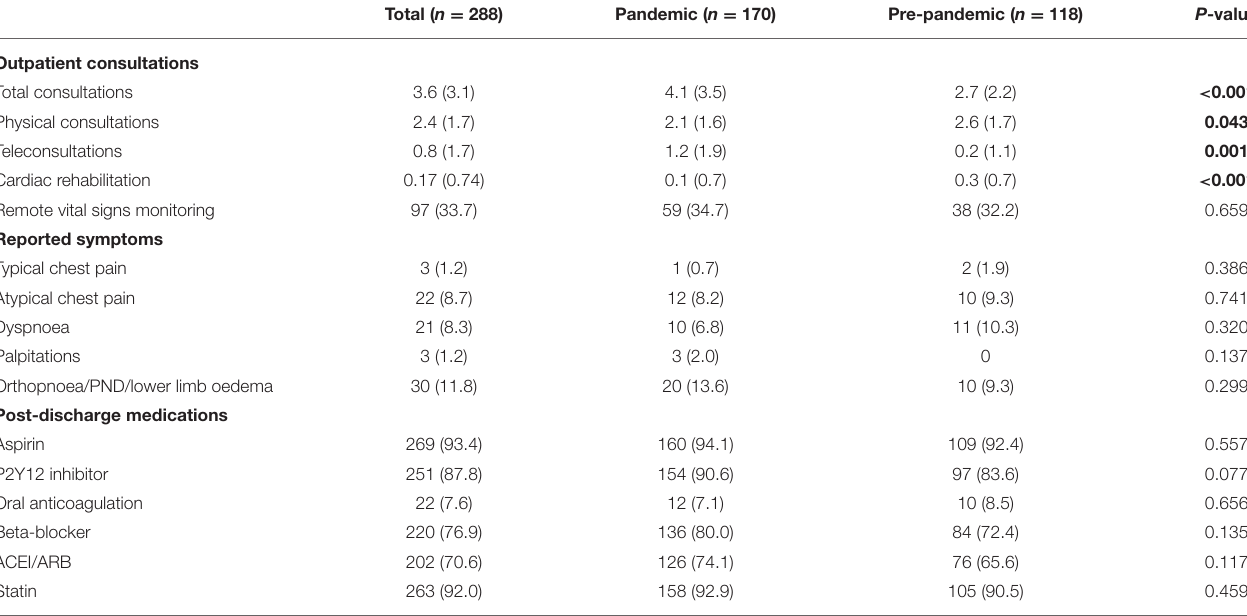
TABLE 2 | Characteristics of study participants with ST-segment elevation myocardial infarction during 1-year follow-up based on pre-pandemic or pandemic